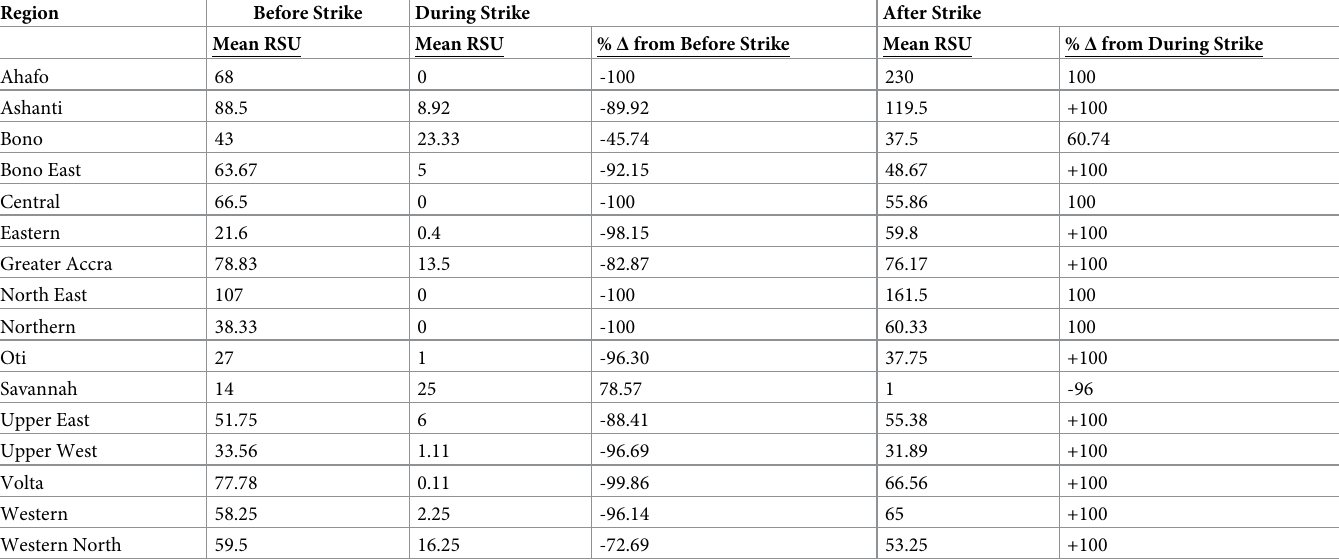
Table 6. Percentage change in the mean reproductive service use (RSU) during and after strike. Region Before Strike During Strike